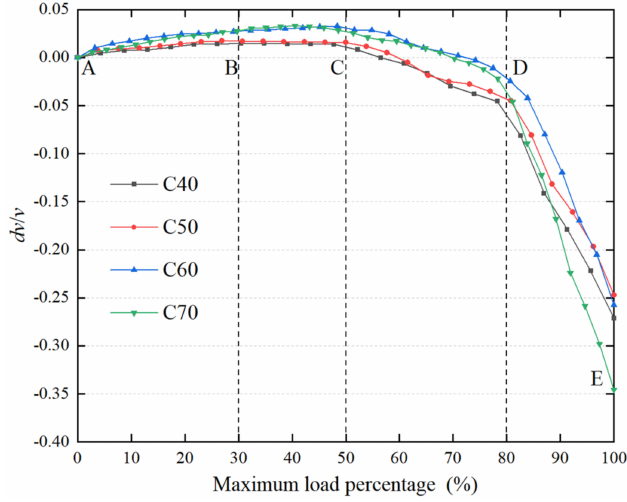
Figure 7. Correlation of the coda wave velocity with the maximum load